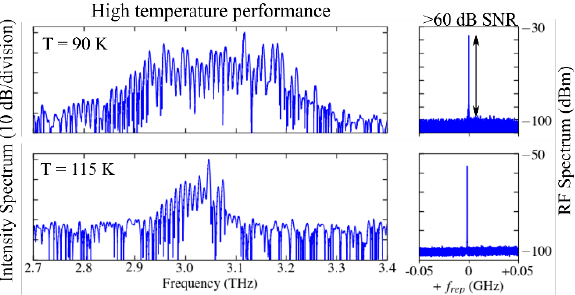
Fig. 3. (a) Free-running tapered waveguide devices produce very strong beatnotes, measured up to nearly -30 dBm at 90 K. (b) The improved frequency comb performance is maintained also for high temperatures, with a bandwidth of 200 GHz and a single beatnote measured above -60 dBm at a heatsink temperature of 115